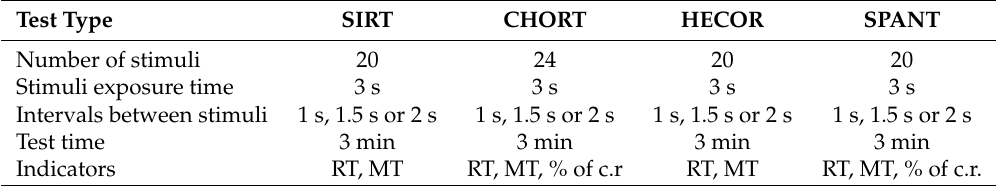
Table 2. Description of psychomotor tests in the Test2Drive